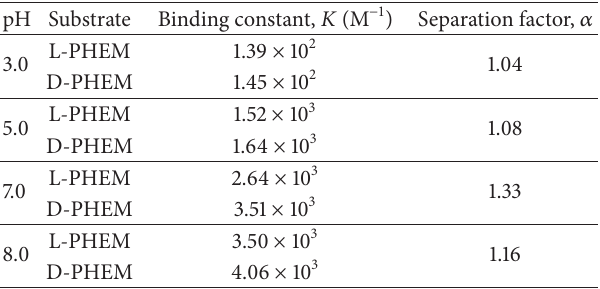
Table 4: The adsorption of L-PHEM and D-PHEM on the D- PHEM-imprinted